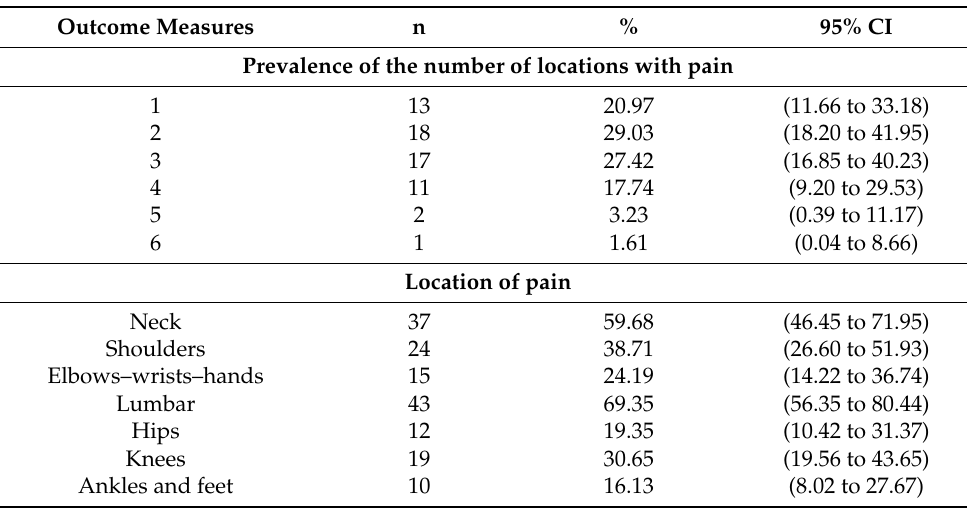
Table 2. Description of the sample population according to the number and location of pain.